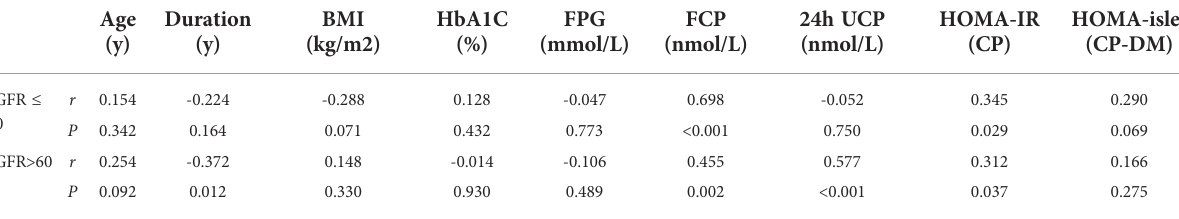
TABLE 3 Correlation analysis between UCPCR and other indicators.